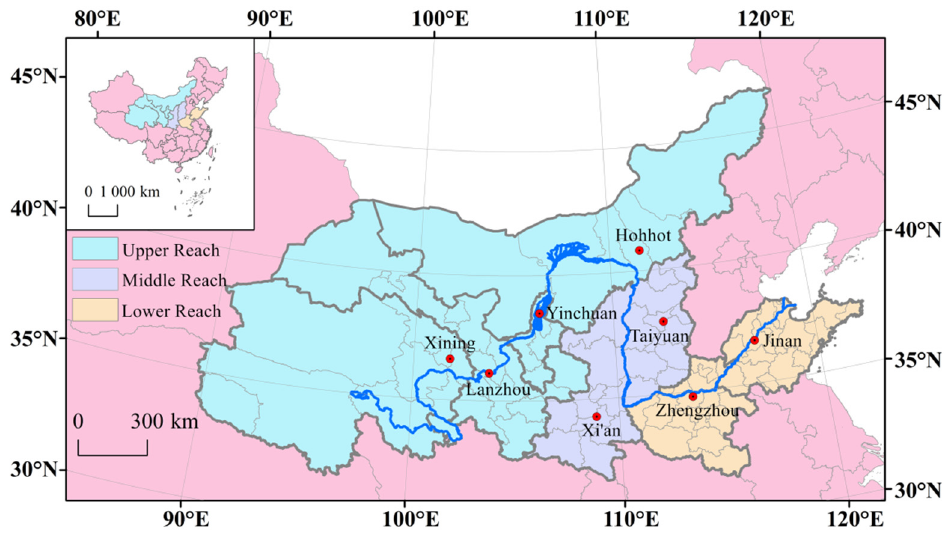
Figure 3. Scope of Study Area.